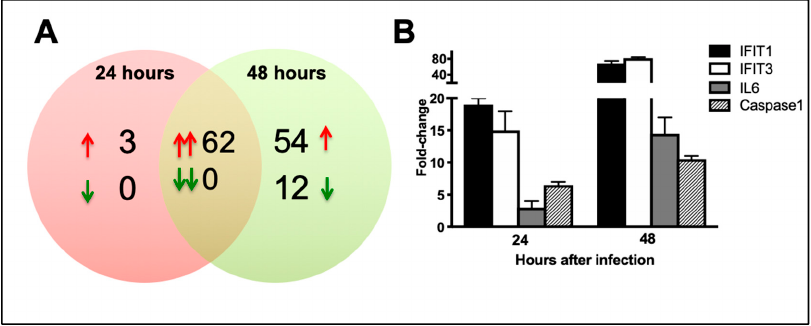
Figure 3. ZIKV infection of the primary mouse neurons causes changes in cellular mRNA expression. Neurons were infected with ZIKV (PRVABC59 strain) or PBS (Mock) at MOI-1. ( A ) Venn diagram showing the number of differentially expressed mRNAs at 24 and 48 h after infection. Sets of upregulated mRNAs are represented by upward red arrows and sets of downregulated mRNAs are represented by downward green arrows. Pairs of arrows in the intersection refer to the number of mRNAs upregulated (double red arrows) or down regulated (double green arrows) at both 24 and 48 h after infection. ( B ) qRT-PCR was conducted on RNA extracted from mock and ZIKV-infected neurons to determine fold-change in IFIT1, IFIT3, IL6, and Caspase1 expression. Changes in the levels of each mRNA were first normalized to the β -actin and then the fold-change in ZIKV-infected cells was calculated in comparison to corresponding mock-infected cells. Data represents the mean ± SEM.